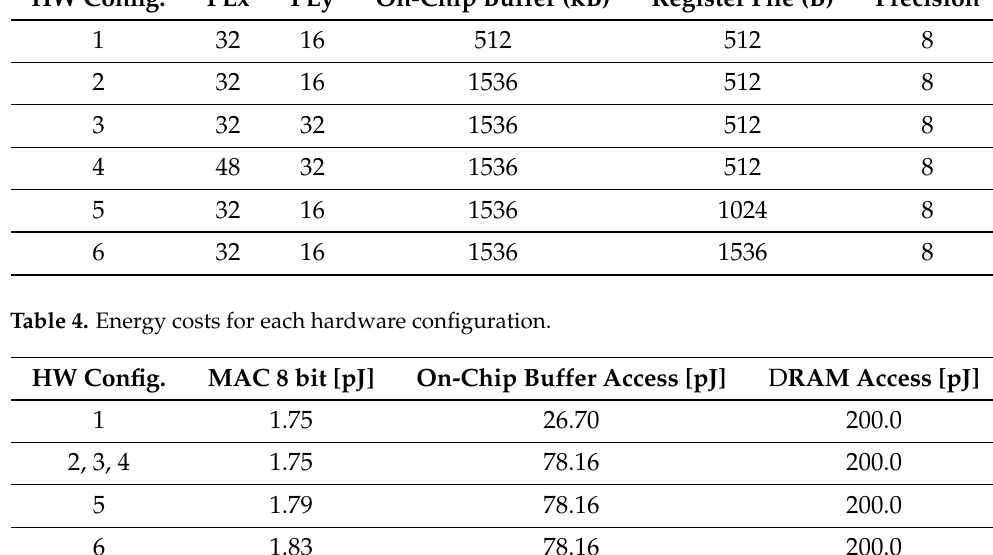
Table 3. Hardware configurations of the row-stationary model accelerator used in the experiments. HW Config.